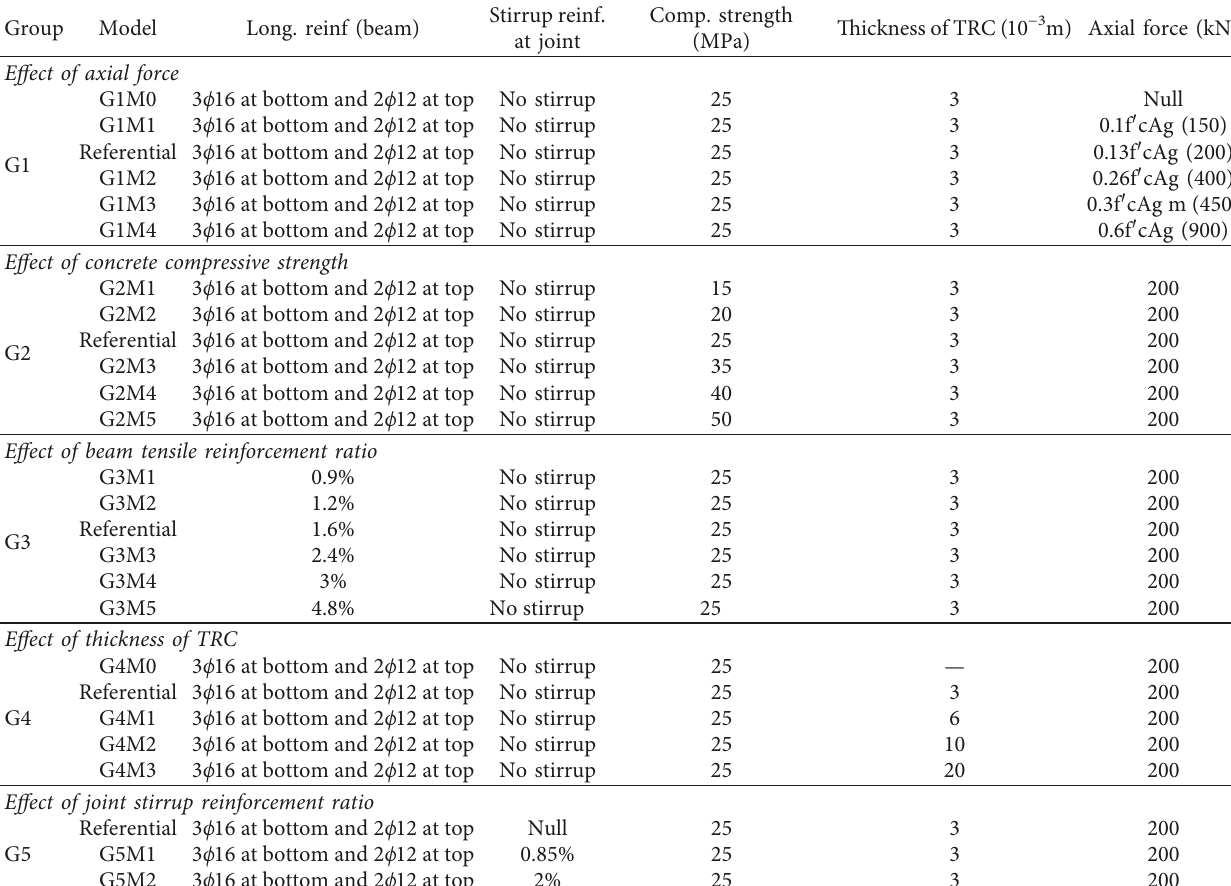
Table 5: Parametric study database and model designation.